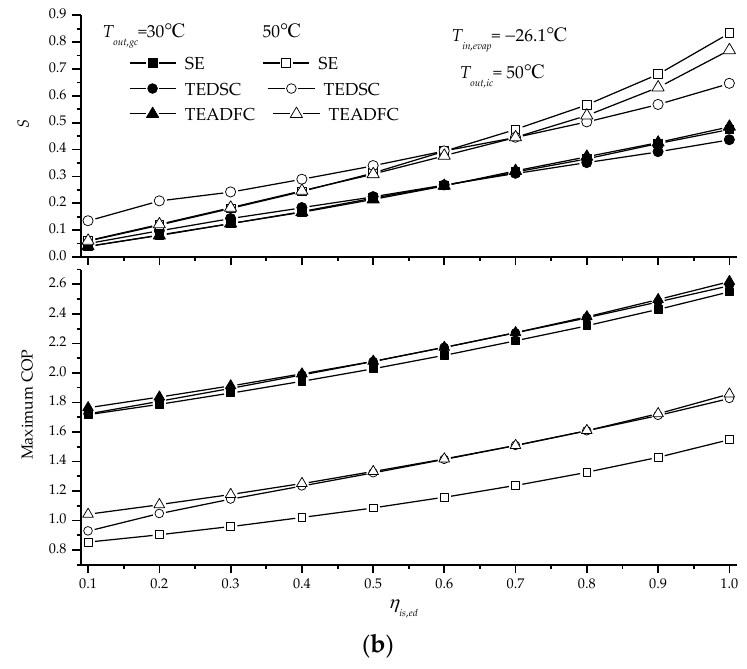
Figure 8. Sensitivity of maximum COP to isentropic efficiency of expander ( a ) different temperature at evaporator inlet; ( b ) different temperature at gas cooler outlet.